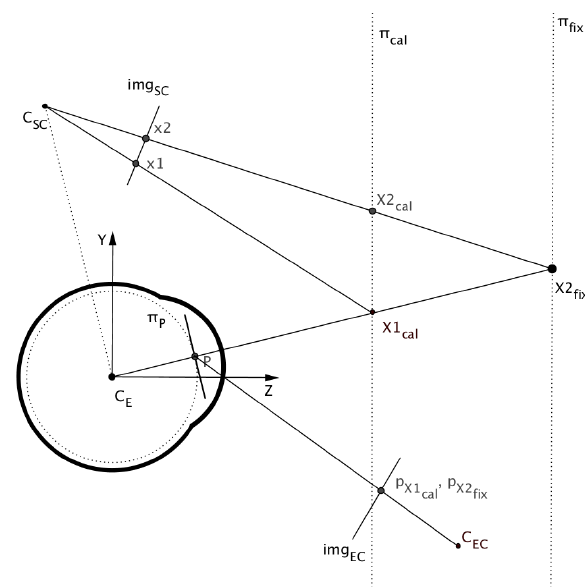
Figure 9 . Sagittal view of a HMGT illustrating the epipolar geometry of the eye and the scene